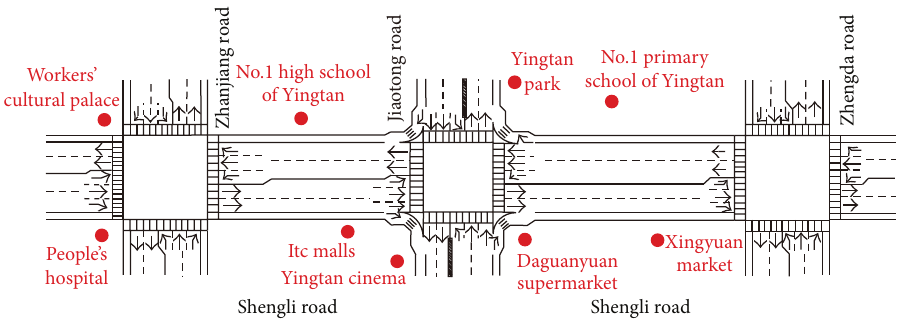
Figure 1: Current intersections and land use along Shengli road.